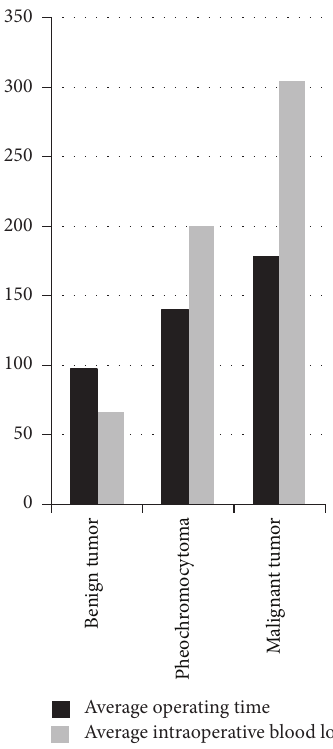
Figure 1: The average operating time and average intraoperative blood loss of different types of tumors. The intraoperative blood loss and average operating time of pheochromocytomas were significantly more than the benign tumors ( 𝑃 < 0.05 ), but malignant tumors between benign tumors or pheochromocytomas were without statistical significance ( 𝑃 > 0.05